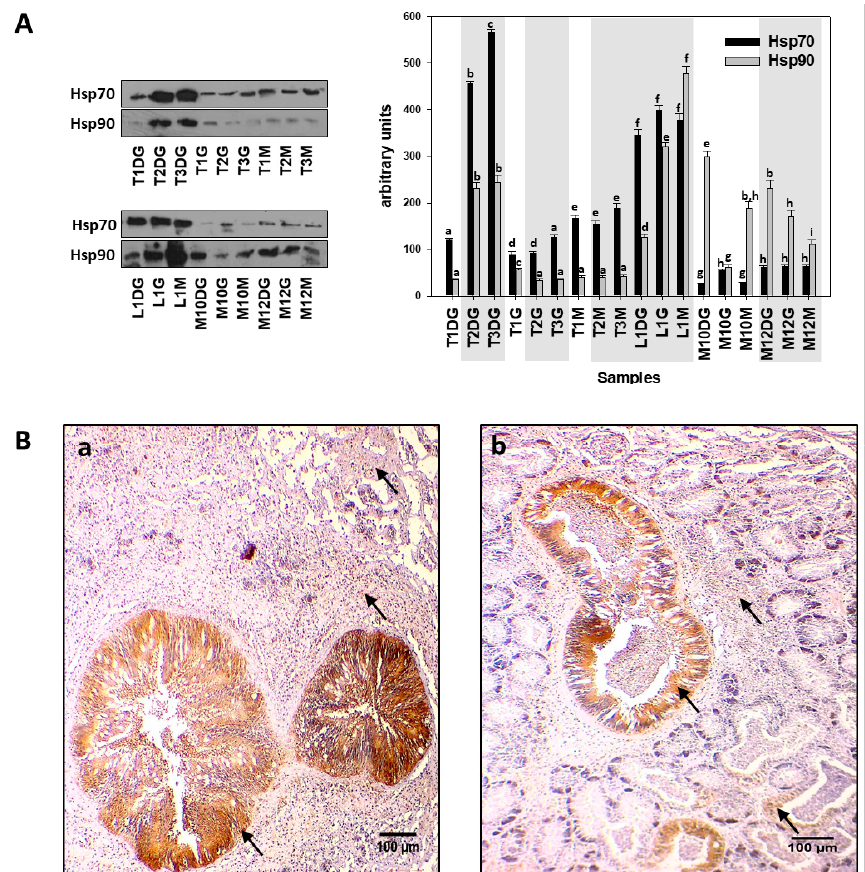
Figure 3. ( A ). Hsp70 and Hsp90 levels in the digestive gland (DG), gills (G), and mantle (M) of Pinna nobilis specimens from the Kalloni Gulf (Lesvos Island) (M10, M12), from Thermaikos gulf (Thessaloniki) (T01, T02, T03), and from Limnos Island (L1). All specimens were infected with mycobacteria and vibrios, while grey shaded areas represent specimens additionally infected with the haplosporidian parasite. Tissue extracts from all groups were immunoblotted for Hsp70 and Hsp90. Blots were quantified using scanning densitometry. Representative blots are shown. Lower-case letters indicate statistically significant differences ( p < 0.05) between samples. ( B ) ( a , b ) Immunohistochemical detection (arrows) of Hsp90 in the digestive tubule and in the connective tissue of the digestive gland of non-infected ( a ) and infected ( b ) specimens from H. pinnae